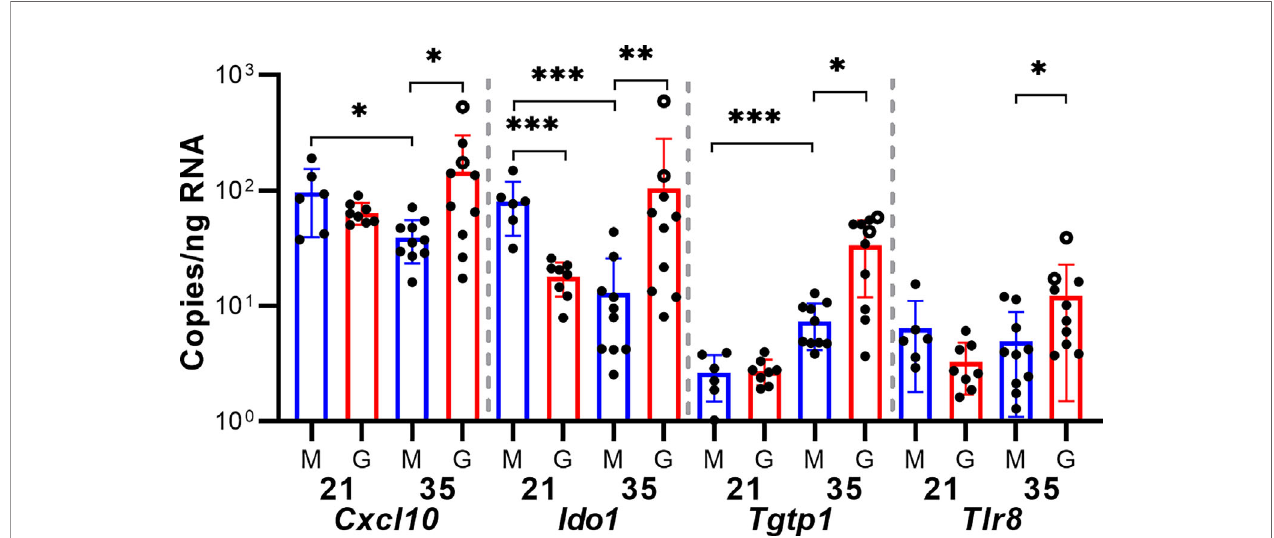
FIGURE 4 | GPCMV infection dysregulates immune gene transcription. A two-step RT-ddPCR protocol was used to quantify the expression of select transcripts in GPCMV- (G) and mock-infected (M) placentas after maternal infection at either 21 or 35 dGA. Data from two placentas per dam is shown. Statistically signi fi cant differences were calculated by Mann-Whitney test (* p < 0.05, ** p < 0.01, *** p <